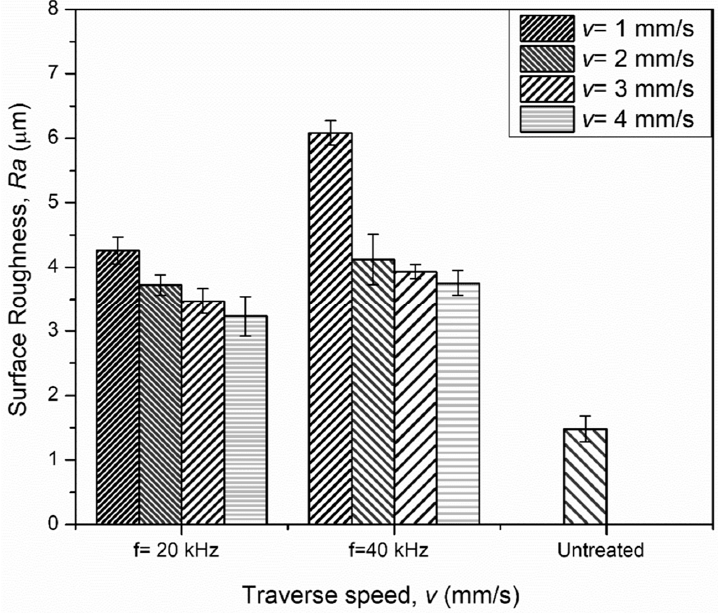
Figure 4. Variation in surface roughness at frequencies of f = 20 kHz [17] and f = 40 kHz at different traverse speeds. traverse